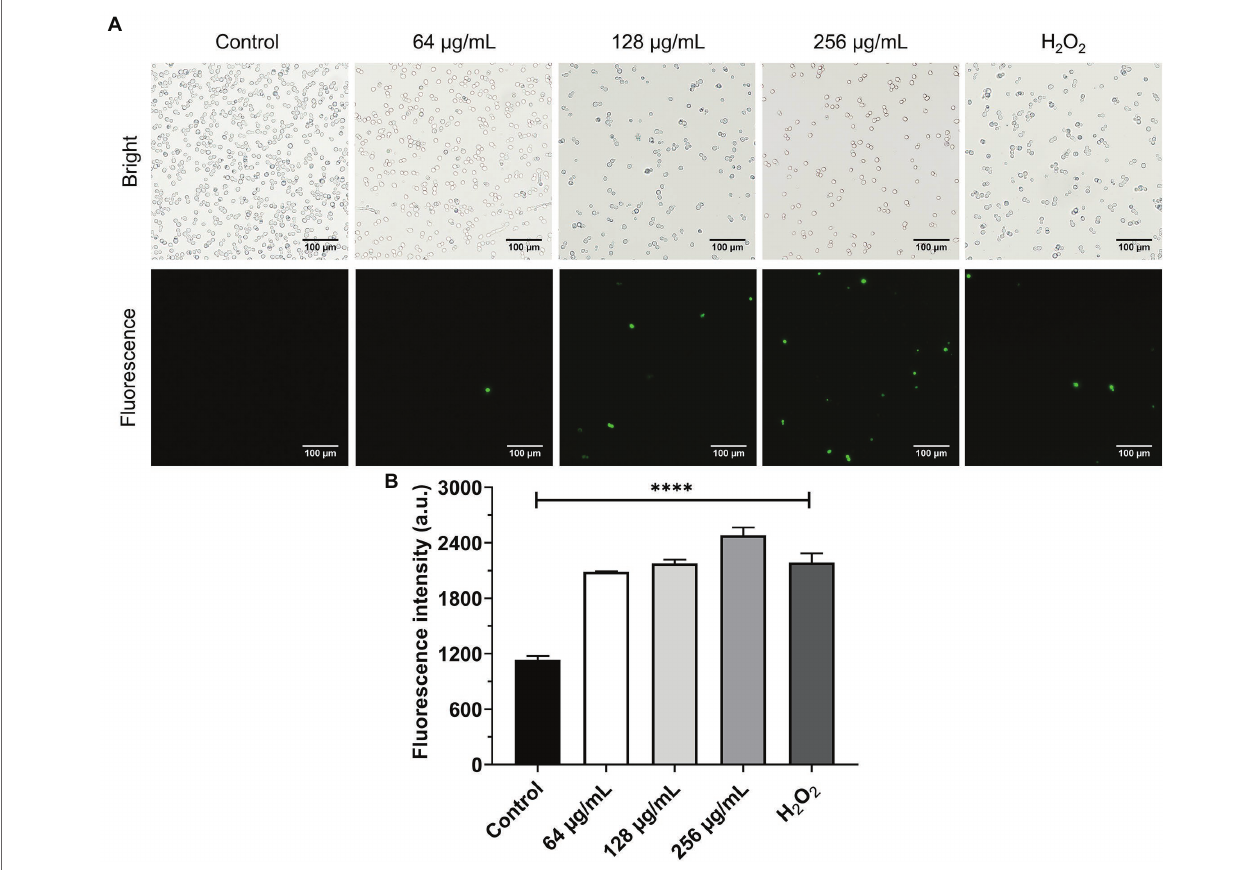
FIGURE 5 | Effect of β -citronellol on ROS production. Approximately 1 × 10 6 cells/mL were treated with β -citronellol and H 2 O 2 (0.2 mM) for 4 h. (A) Morphology of yeast under bright field and fluorescence microscope. (B) Fluorescence intensity of the H 2 DCFDA probe at excitation/emission wavelength 485/535 nm. Data are represented as mean ± SD. **** p ≤ 0.0001 compared to the